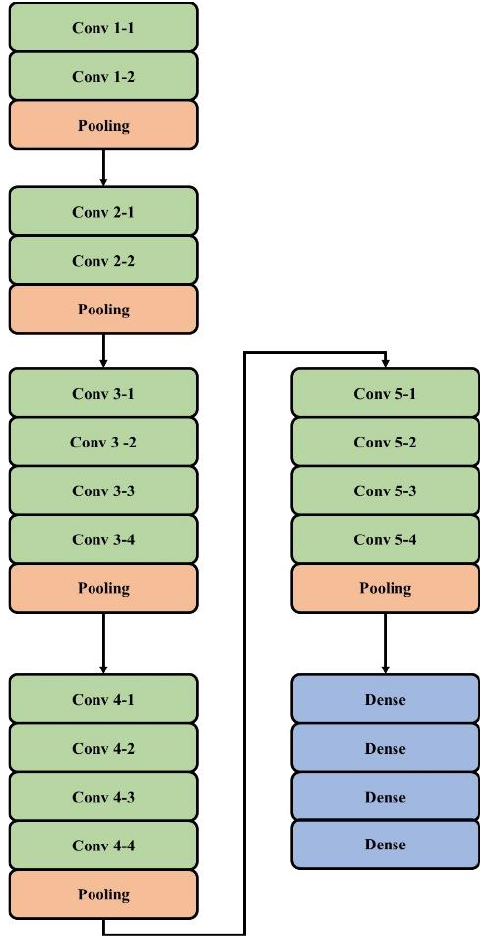
Figure 4. VGG19 architecture for feature extraction.